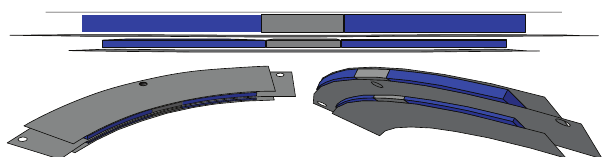
Figure 7: Theoretical model of the CLD.